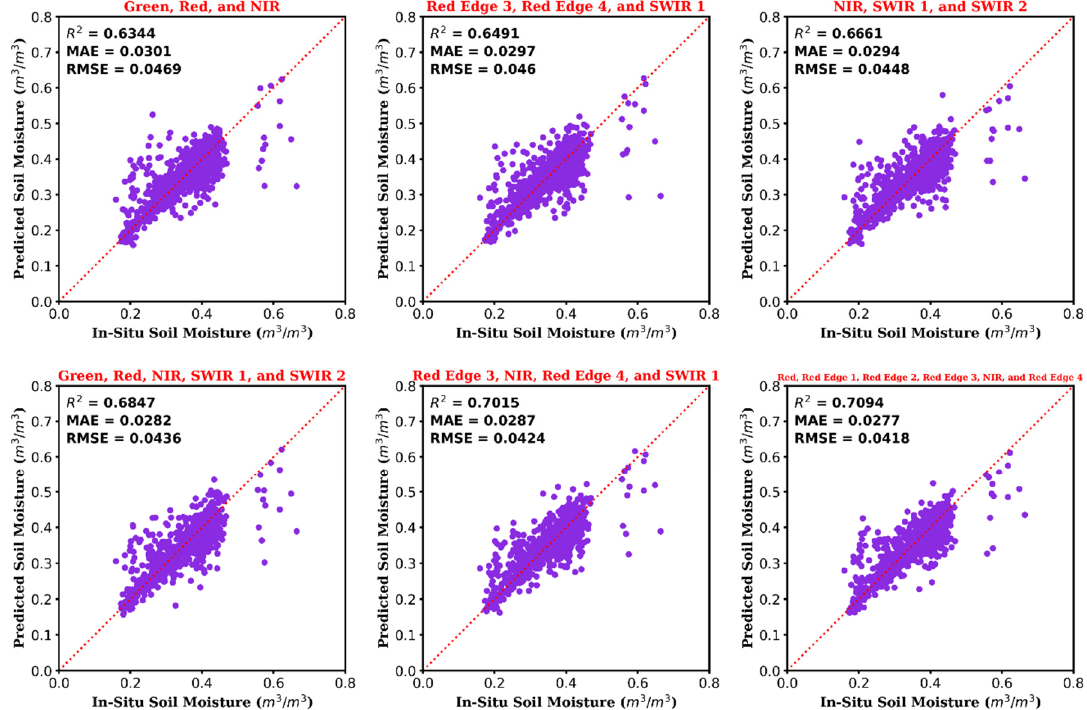
Figure 5. Results of using combinations inferred as input data to the CNN architecture